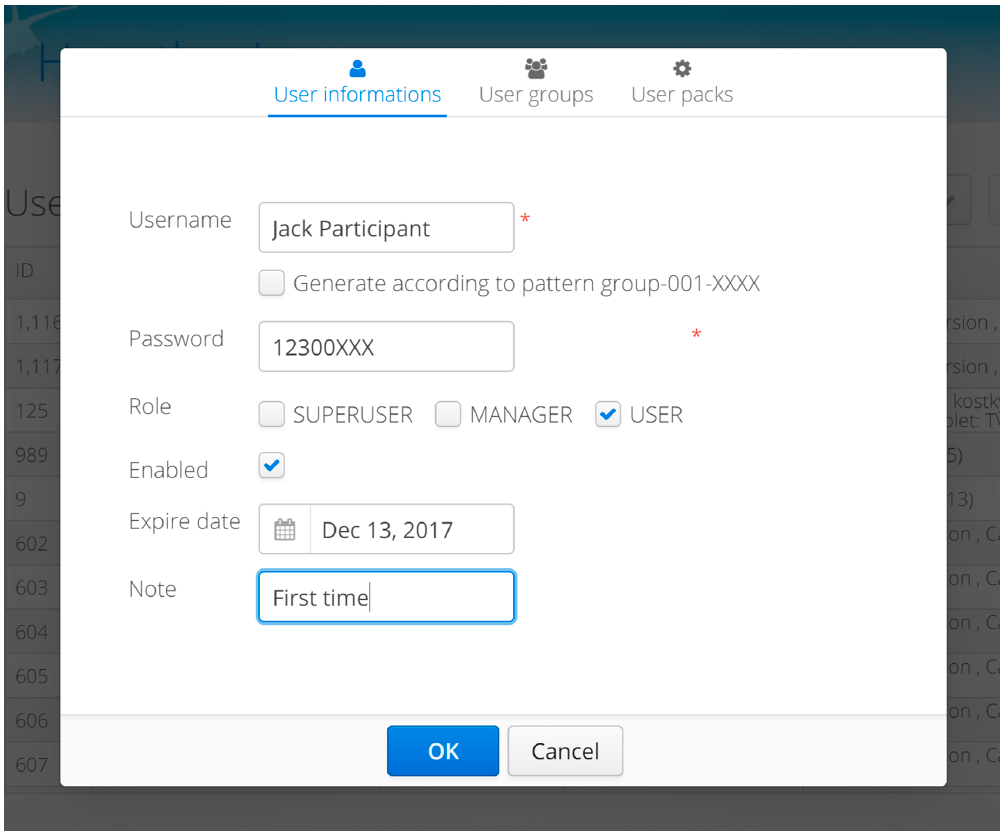
Figure 7. Sample Administrator Account. Editing of a new user account.